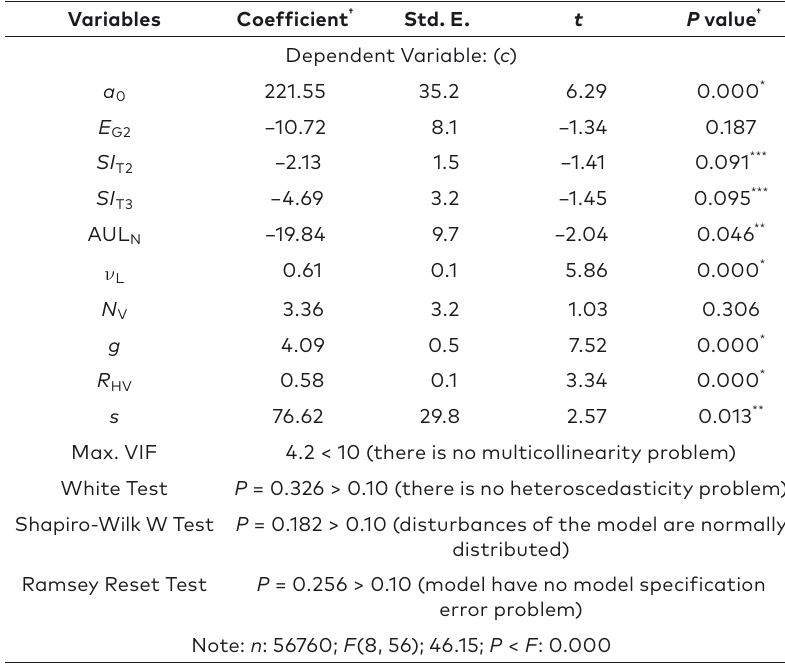
Table 5. Results of the predicted model for the lane capacity ( c ) of signalized